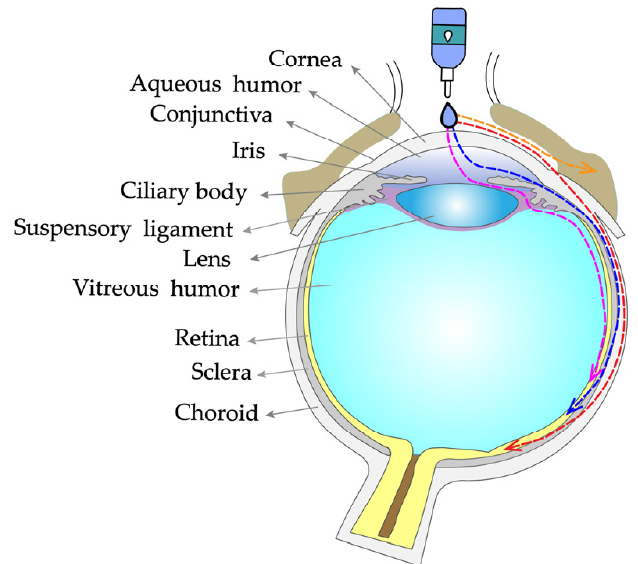
Figure 2. Different topical drug absorption routes from the cornea/conjunctiva–sclera to the posterior segment of the eye. Conjunctival–scleral route marked in red. Uveal–scleral route marked in blue. Transvitreal route marked in rose. Orange marks the systemic absorption route.